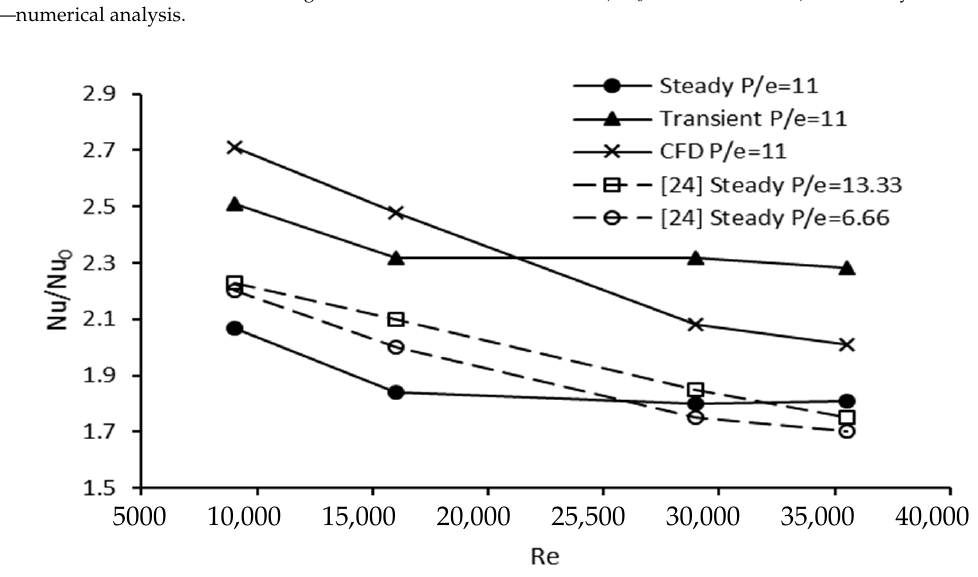
Figure 23. Experimental and normalized Nusselt number versus the Reynolds number obtained by the authors and Tanda and Abram [25] for Configuration_4. Figures 22 and 23 show the normalized Nusselt number (by Dittus-Boelter correlation) versus the Reynolds number only for configuration _3 and _4 obtained by steady state, transient method and CFD for comparison with the values obtained by Tanda and Abram (steady state method only) [25]. Data from Tanda and Abram for one (1RW) and two (2RW) ribbed wall channels with rib turbulators inclined at 45 degrees were also added to the graph, since the configuration and operating conditions were similar to those considered here. When ribs are applied to the bottom plate only, the larger pitch (P/e = 11) provides a slightly higher heat transfer than the smaller rib pitch (P/e = 6.6), by 7% on average. Adding the ribs to the upper plate increases the turbulence level for both values of P/e and enhanced heat transfer coefficient by up to 25% depending on the Reynolds number and configuration (see Tables 1 and 2).